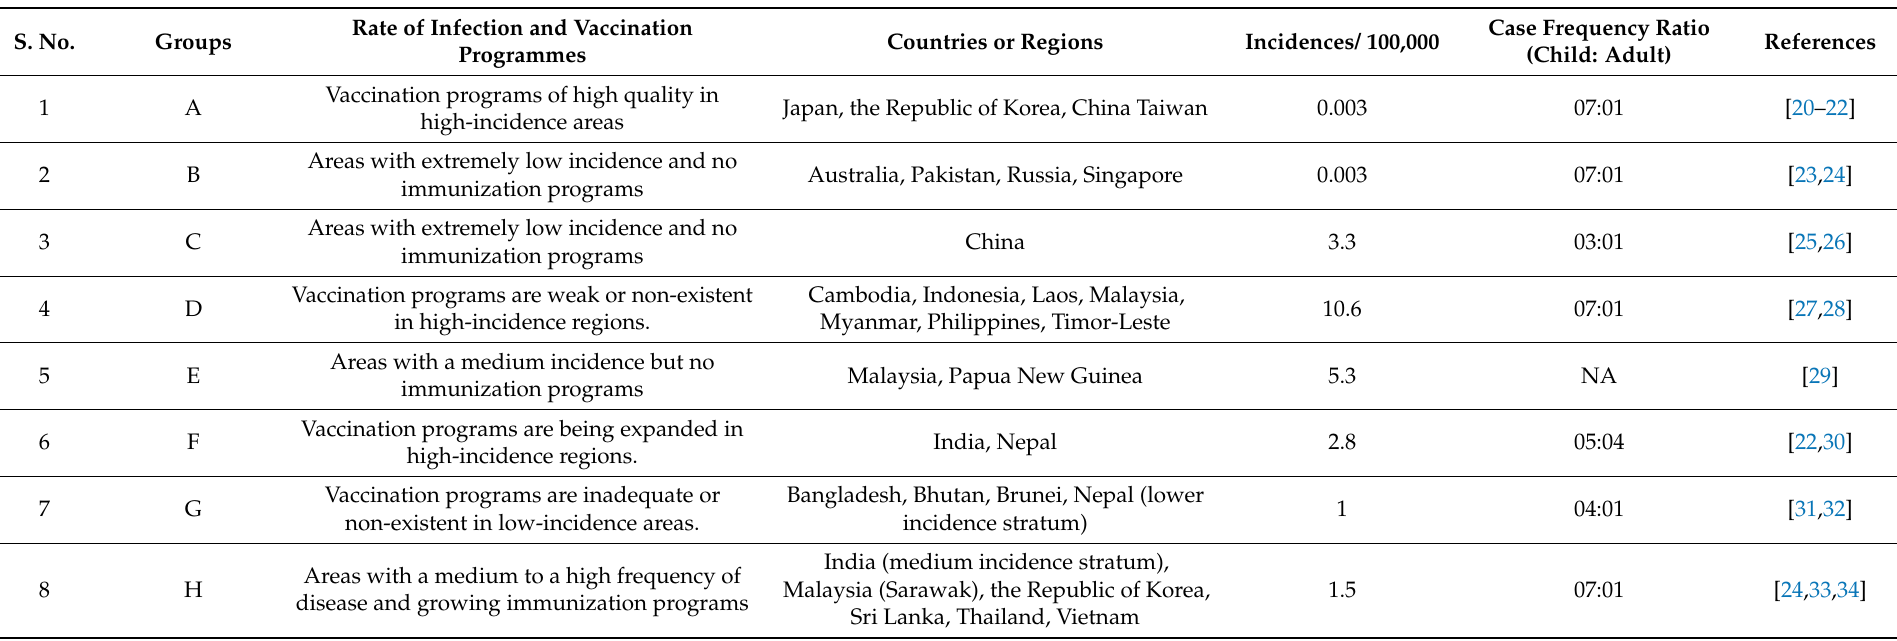
Table 1. Classification of eight groups of countries or regions affected by JEV on the basis of their vaccination program. S. No.